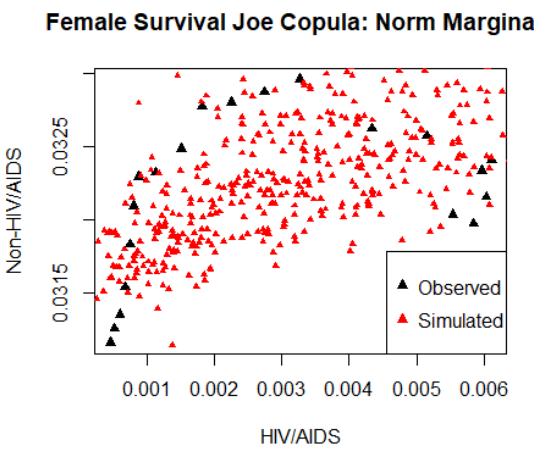
Figure 14. Normal marginal distribution for females.